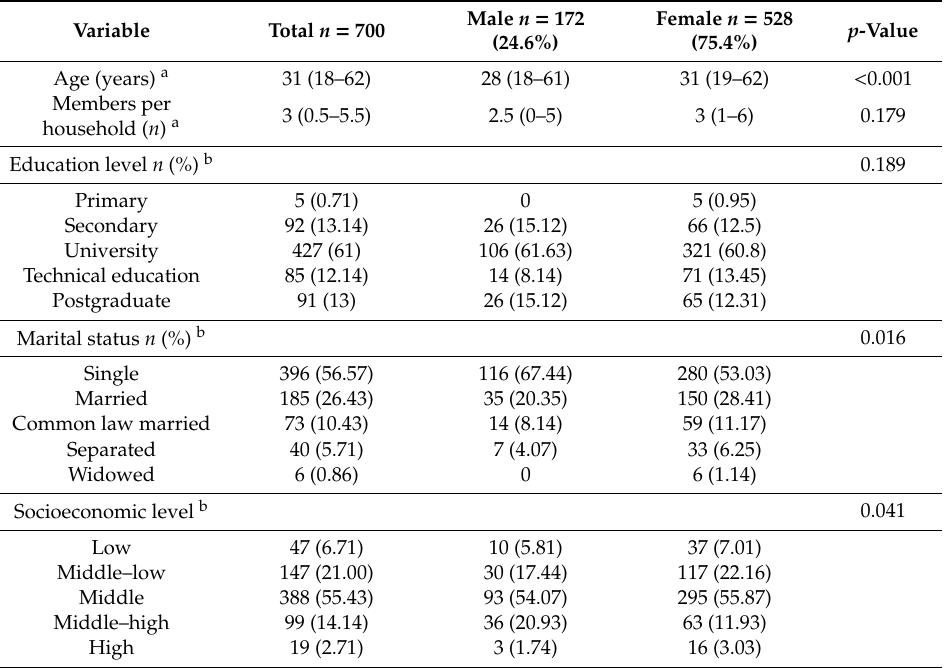
Table 1. Sociodemographic characteristics of the study